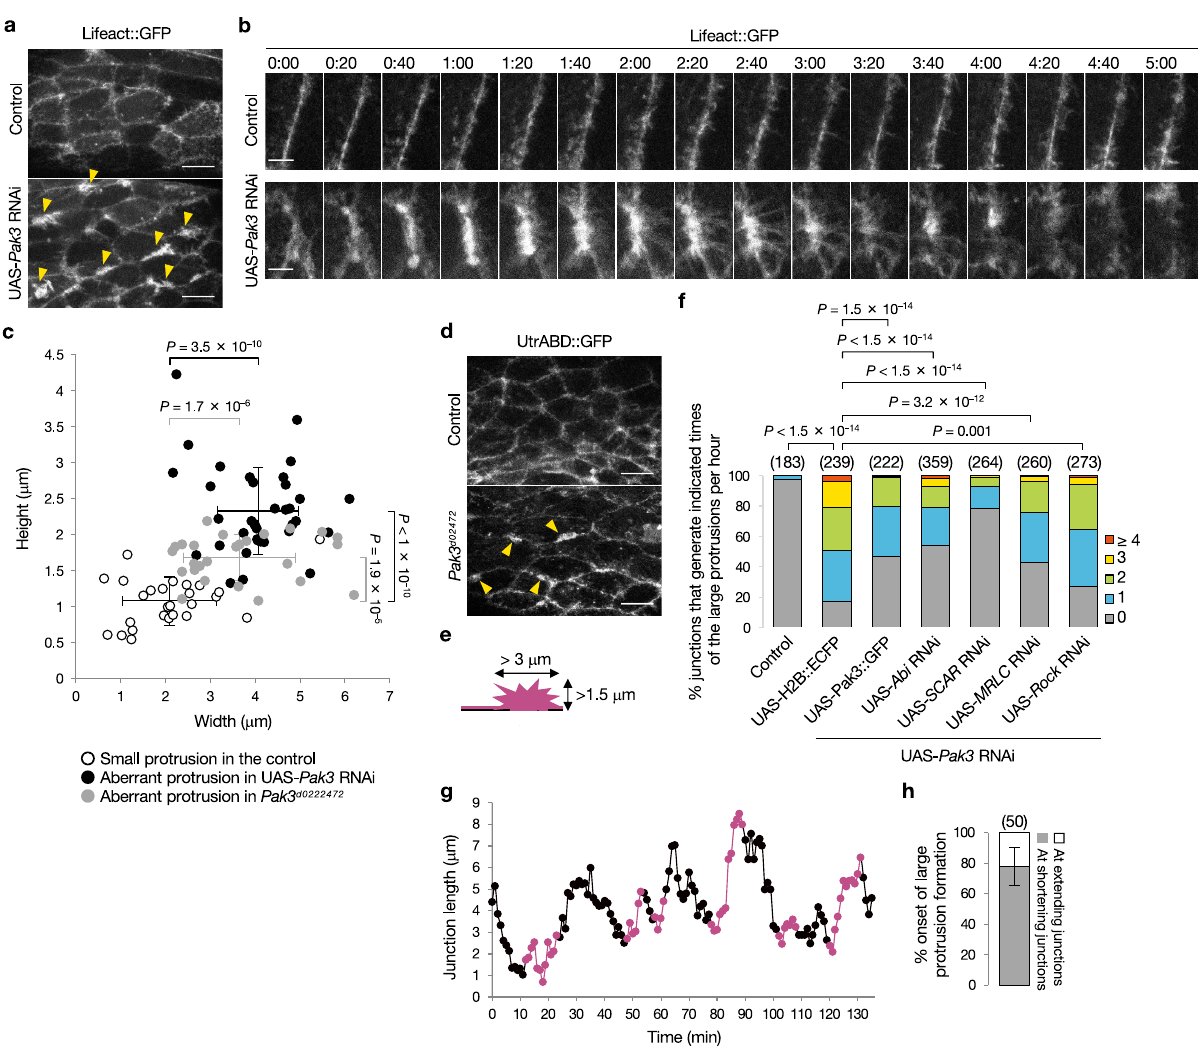
Fig. 2 Pak3 depletion induces aberrant actin dynamics. a Representative images of actin labeled with Lifeact::GFP in the A8a cells from >3 independent experiments. Arrowheads indicate some aberrant actin protrusions. Scale bar, 10 μ m. b Magni fi ed time-lapse images of Lifeact::GFP at cell – cell junctions, representative of >3 independent experiments. Scale bar, 3 μ m. c Mean± S.D. of the height and width of small actin protrusions in the control cells and aberrant protrusions in the Pak3-depleted cells. n = 26 (control and Pak3 RNAi) or 36 ( Pak d02472 ) protrusions from 5 (Control and Pak3 RNAi) or 2 ( Pak3 d02472 ) biologically independent pupae per genotype. P- values by two-tailed Dunnett ’ s test. d Representative images of actin labeled with UtrABD::GFP in the A8a cells from two independent experiments. Arrowheads indicate some aberrant actin protrusions. Scale bar, 10 μ m. e A schematic illustration of the large actin protrusions (magenta) at a junction (black). f Percentages of junctions generating the large actin protrusions for the indicated number of times per hour are shown. Parentheses, the number of examined junctions from 4 to 5 pupae per genotype. P- values by two-tailed Mann – Whitney U -test. g Graph showing the length of a representative junction that repeats shortening and re-extension in Pak3 RNAi cells. The timings when the large actin protrusions emerge are shown in magenta. h Mean± S.D. of the timing of the onset of the large actin protrusion formation. Parenthesis indicates the number of protrusions from 15 junctions of 3 pupae. Genotypes: a – c + /Y;UAS-Lifeact::GFP/ + ;AbdB-Gal4/ + (Control) and + /Y;UAS-Lifeact::GFP/ + ;AbdB-Gal4/UAS-Pak3 RNAi ; d + /Y;sqh-UtrABD::GFP/ + (Control) and + /Y;sqh-UtrABD::GFP/ + ;Pak3 d02472 ; f + /Y;UAS- Lifeact::GFP/ + ;AbdB-Gal4/ + (Control), + /Y;UAS-Lifeact::GFP/ + ;AbdB-Gal4, UAS-H2B::ECFP/UAS-Pak3 RNAi , + /Y;UAS-Lifeact::GFP/ + ;AbdB-Gal4, UAS- Pak3::GFP/UAS-Pak3 RNAi , + /Y;UAS-Lifeact::GFP/UAS-Abi RNAi;AbdB-Gal4/UAS-Pak3 RNAi , + /Y;UAS-Lifeact::GFP/UAS-SCAR